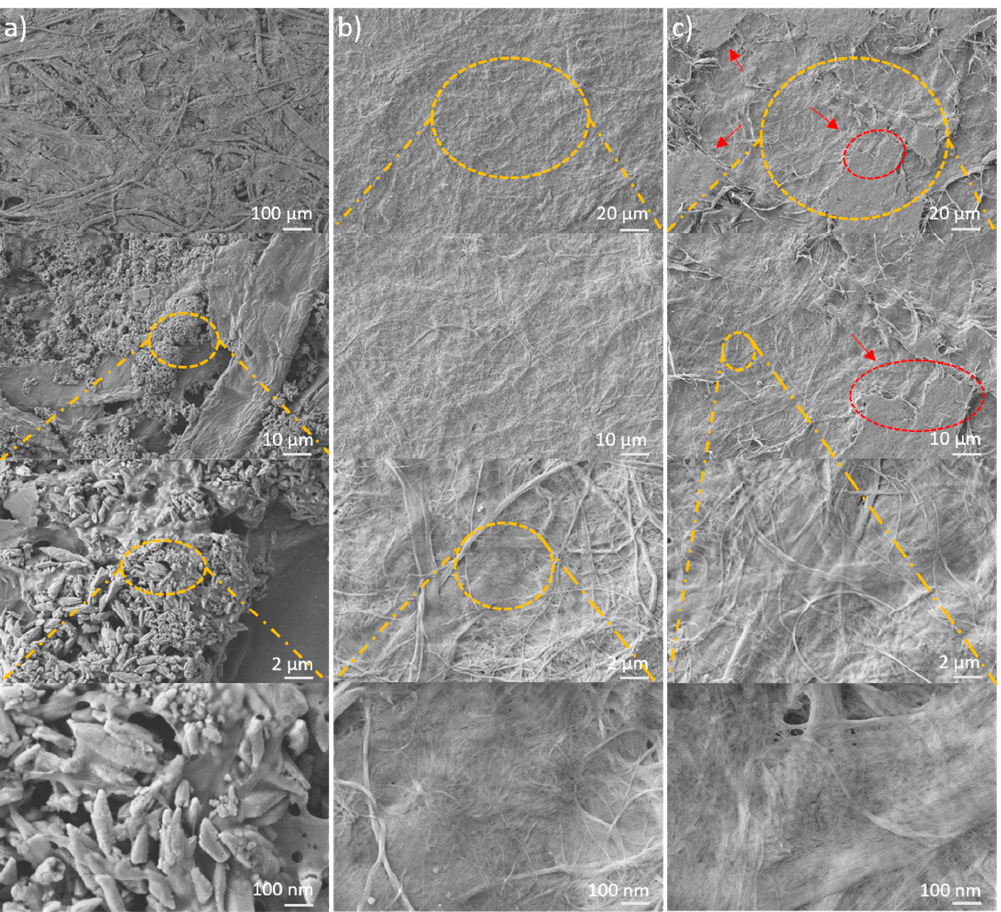
Figure 5. Surface SEM images of ( a ) paper substrate, ( b ) paper coated with CNF and ( c ) paper coated with LCNF at different magnitudes.